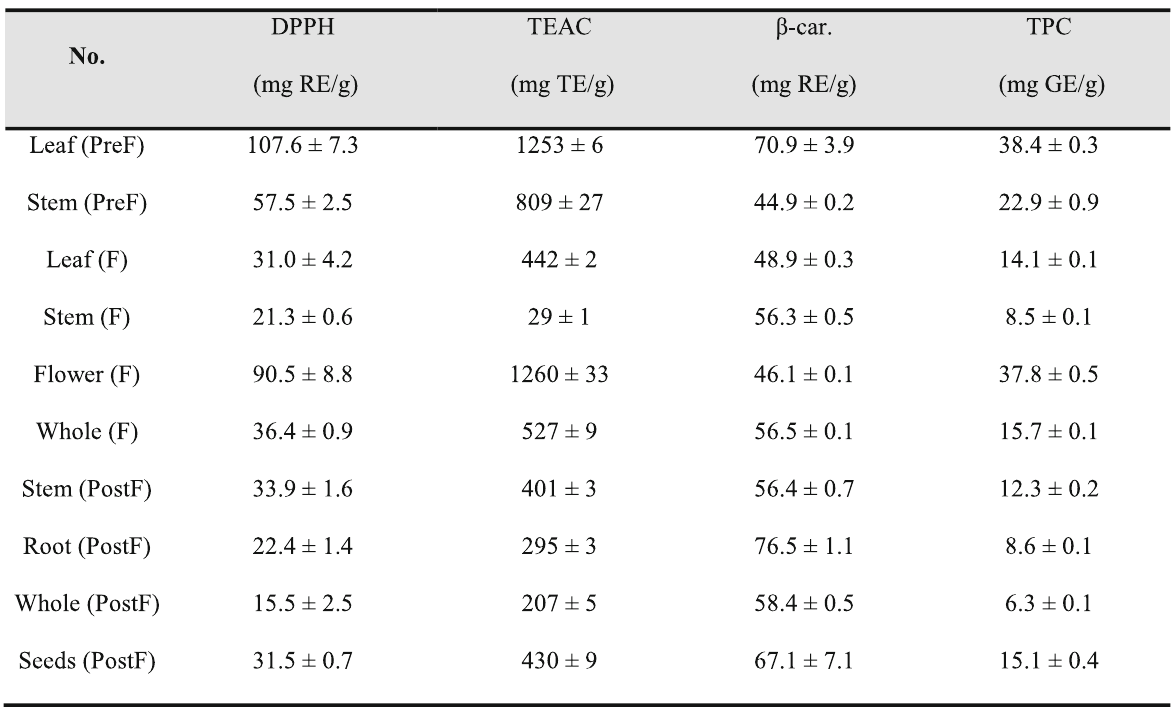
Table 3 In vitro antioxidant activity evaluation using three distinct methods and total phenolic content (TPC). Results are expressed in rutin equivalents (RE), trolox equivalents (TE) and gallic acid equivalents (GE) in dried extract